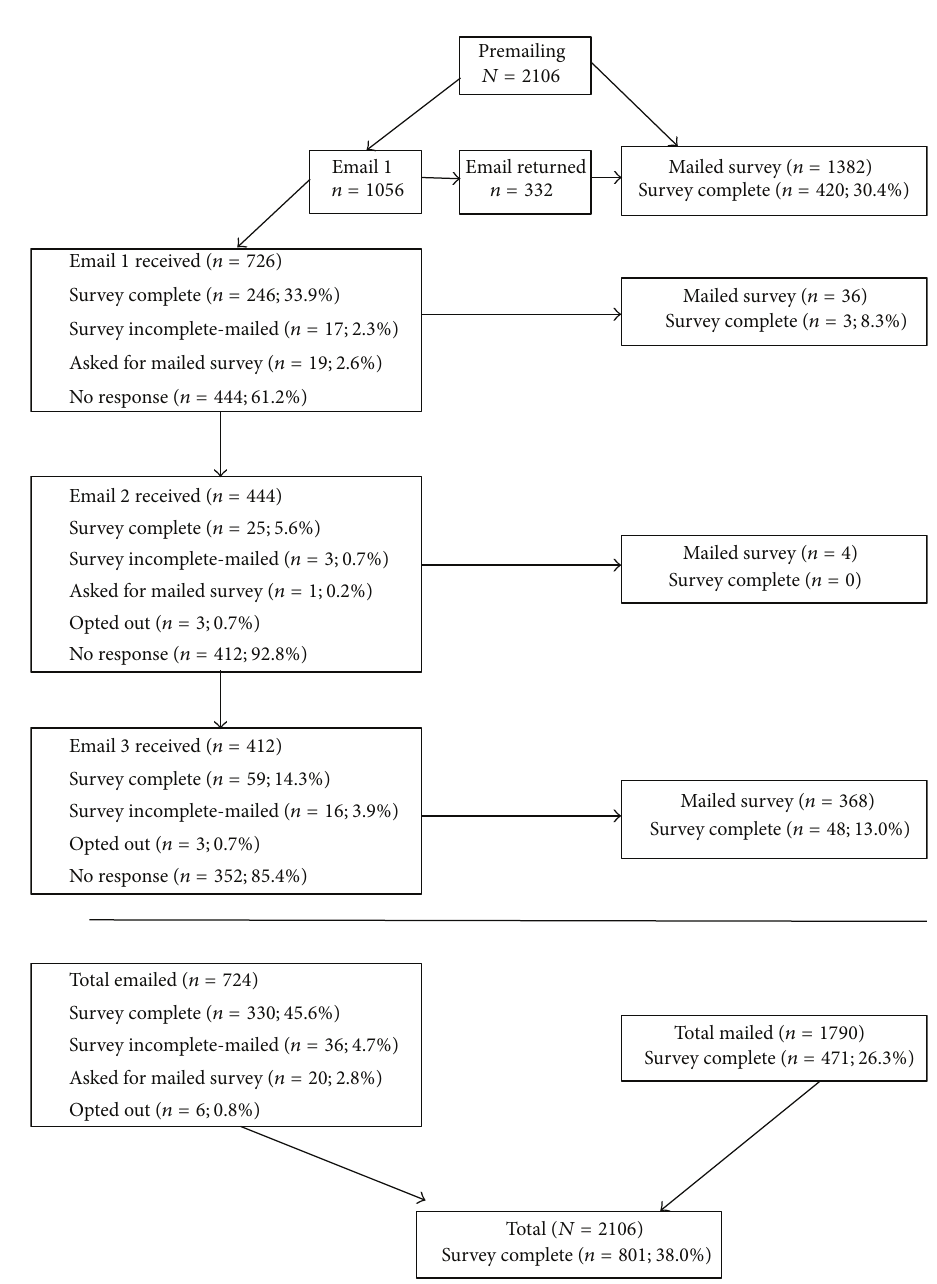
Figure 1: Sample phases and response